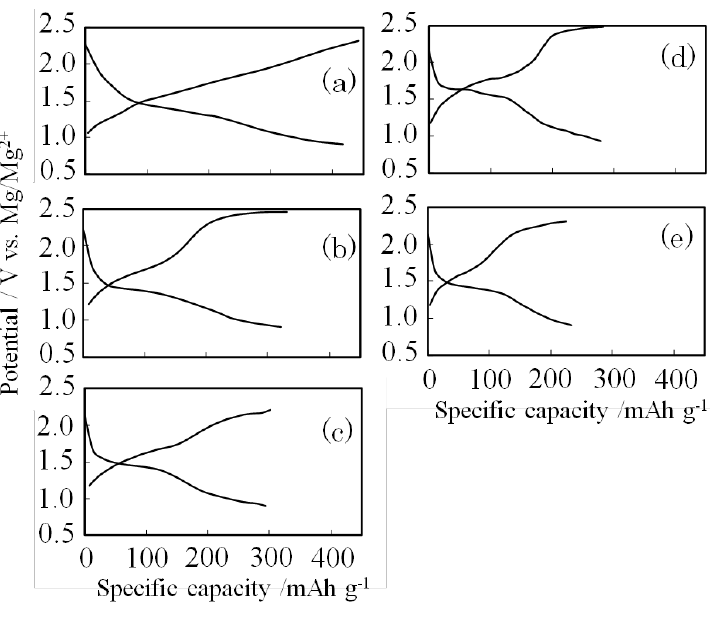
Figure 4. Charge-discharge curves at second cycle: ( a ) MnO NiO; and ( e ) ZrO